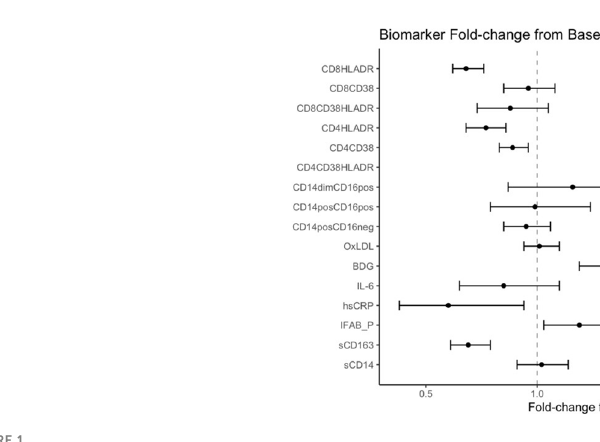
FIGURE 1 Fold Change from baseline over 96 weeks. Point estimates and error bars re fl ect mean and 95% con fi dence intervals.